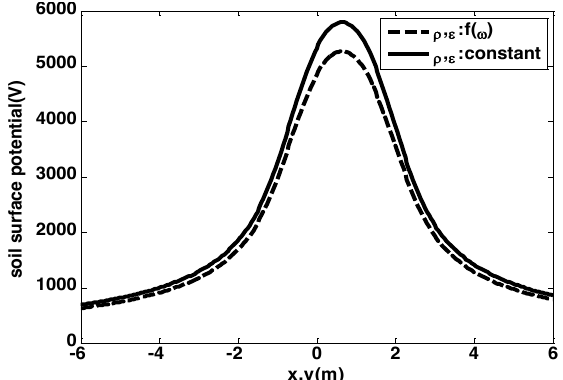
Figure 18: Induced voltage on the soil surface of grounding grid from example 2.